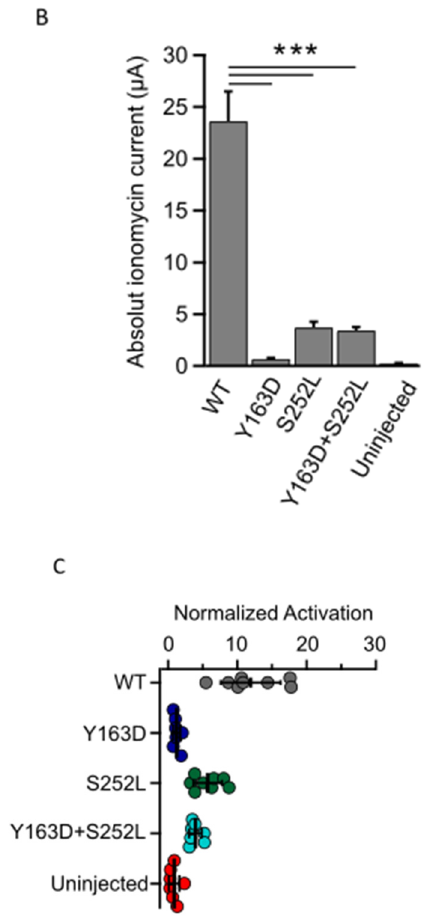
Figure 3. KCNK18 p.Tyr163Asp and p.Ser252Leu impair the ionomycin-induced activation of TRESK channels. Repre- sentative data points showing ionomycin activation of TRESK WT, Y163D, S252L and Y163D + S252L currents as well as endogenous currents from un-injected oocytes. ( A ). Currents were evoked by 300 ms long voltage steps from 0 mV to − 100 mV from oocytes injected with 1 ng of mRNA of the corresponding and indicated homomeric channel type and 0.5 ng for each subunit for the heteromeric channel Y163D/S252L. The sampled data represent the average of 50 ms long period of the steady-state currents recorded at − 100 mV. Ionomycin activates the WT channels but has little effect on the oocytes that express the mutant channels or those that are uninjected. Note that the current decay upon reapplication of a solution containing 2 mM K + in the recording chamber is due to the reduced K + concentration rather than ionomycin washout. ( B ). Bar graph showing the mean of ionomycin activated currents (*** p < 0.001). All the groups were statistically significant compared to the uninjected group (WT vs. uninjected p < 0.001; Y163D vs. uninjected p = 0.02; S252L and Y163D + S252L vs. uninjected p < 0.01; n = 12). ( C ). Each point represents the steady state ionomycin activated current divided by the steady-state basal current (I Iono /I Basal ) recorded in the presence of 80 mM extracellular K + .